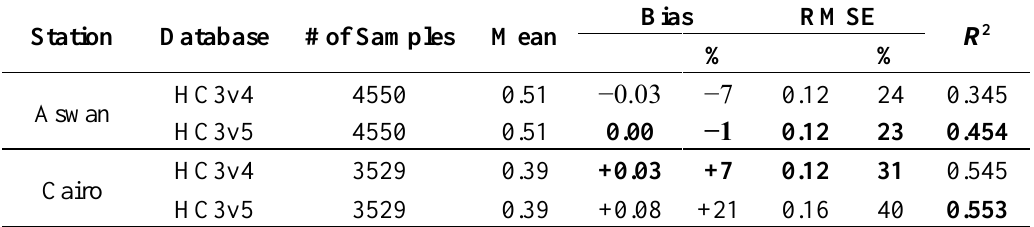
Table 9. Validation of the direct normal clearness index KT Bn under all-sky conditions, the best values for each station are in